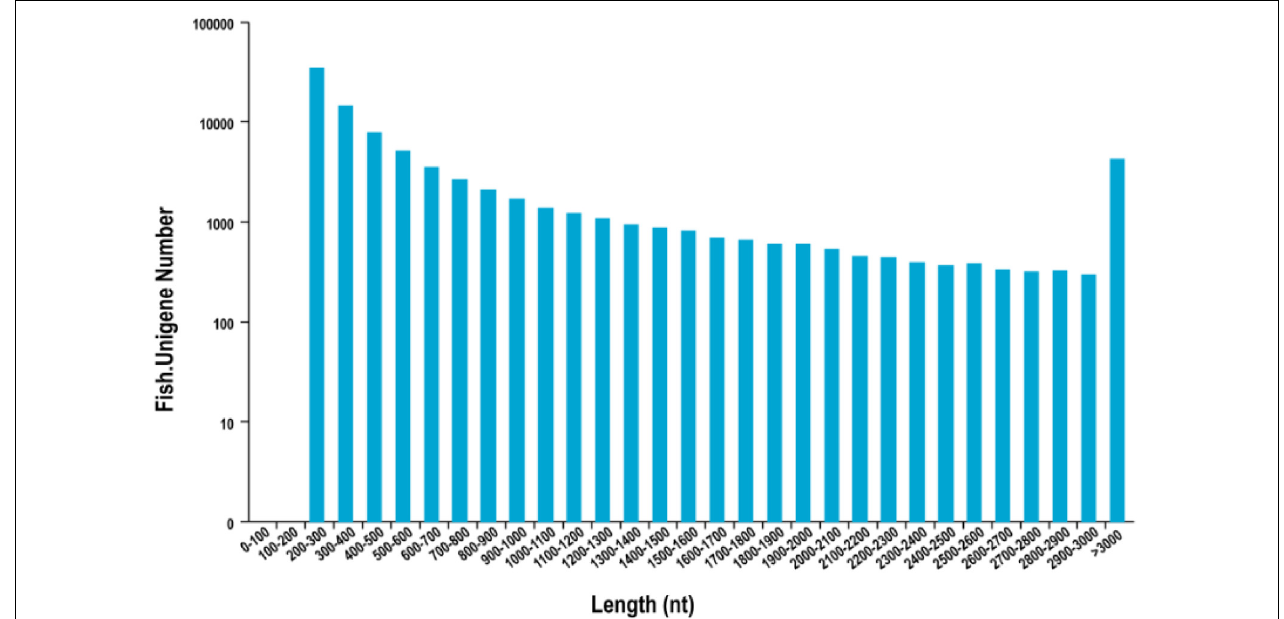
FIGURE 1 | Length distribution of assembled unigenes. X -axis: length, Y -axis: Unigene number.